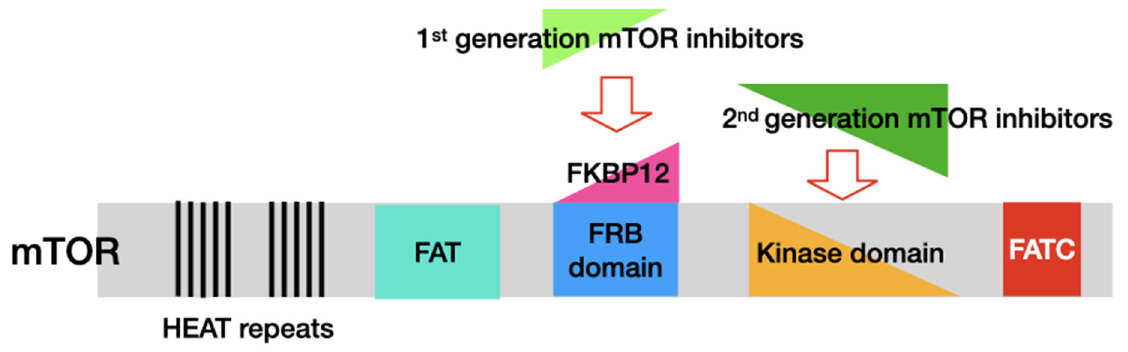
Figure 2. Domains of the mTOR protein and two generations of mTOR inhibitors.